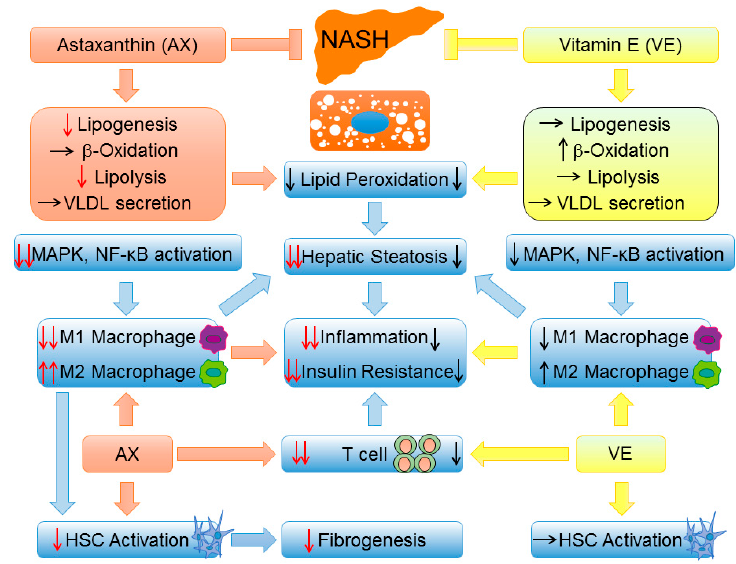
Figure 2. A brief comparison of NAFLD/NASH prevention and therapy between astaxanthin and vitamin E. First, astaxanthin is more effective than vitamin E in improving steatosis by suppressing lipid accumulation. Second, astaxanthin is superior to vitamin E with respect to suppressing the MAPK pathway and NF- κ B activation and induces a strong shift of M2 macrophage polarization, which ultimately reverses hepatic steatosis, inflammation, and insulin resistance. Most importantly, as a result of M1/M2 transformation, astaxanthin can reduce hepatic stellate cell (HSC) activation and ameliorate hepatic fibrosis. Black arrow: ↑ : induction, ↓ : inhibition, → : no change; Red arrow: ↓ : inhibition compared with vitamin E, ↑↑ / ↓↓ : more significant induction/inhibition effect compared with vitamin E.